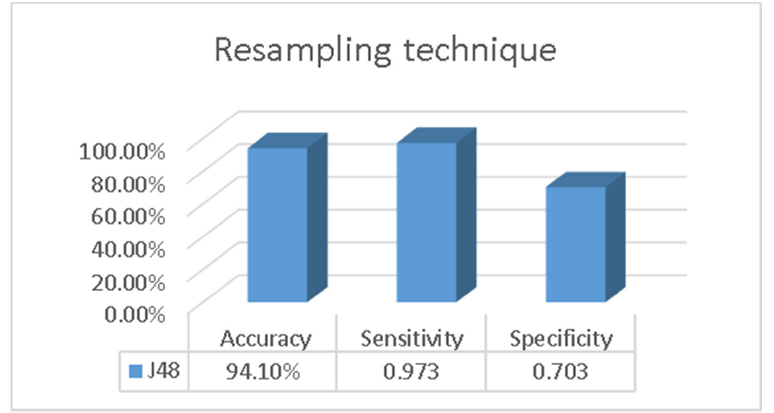
Figure 4. Compared accuracy, specificity and sensitivity for J48 after using a resampling technique. When using the attribute evaluator for the J48 model, the 12 selected attributes from the 20 that were input, resulted in an increased number of correctly classified instances, as shown in Table 3. Table 3. Variables selected after using WappedSubsetEval to dimension